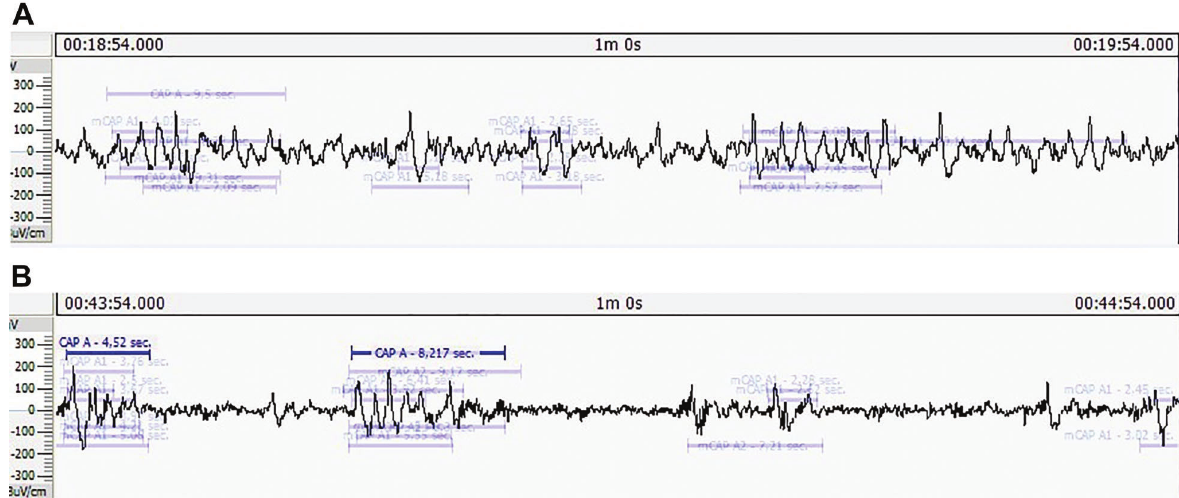
Figure 8. Sleep stage N2, one-min epoch scorings. We found disagreement between scorers ( A and B